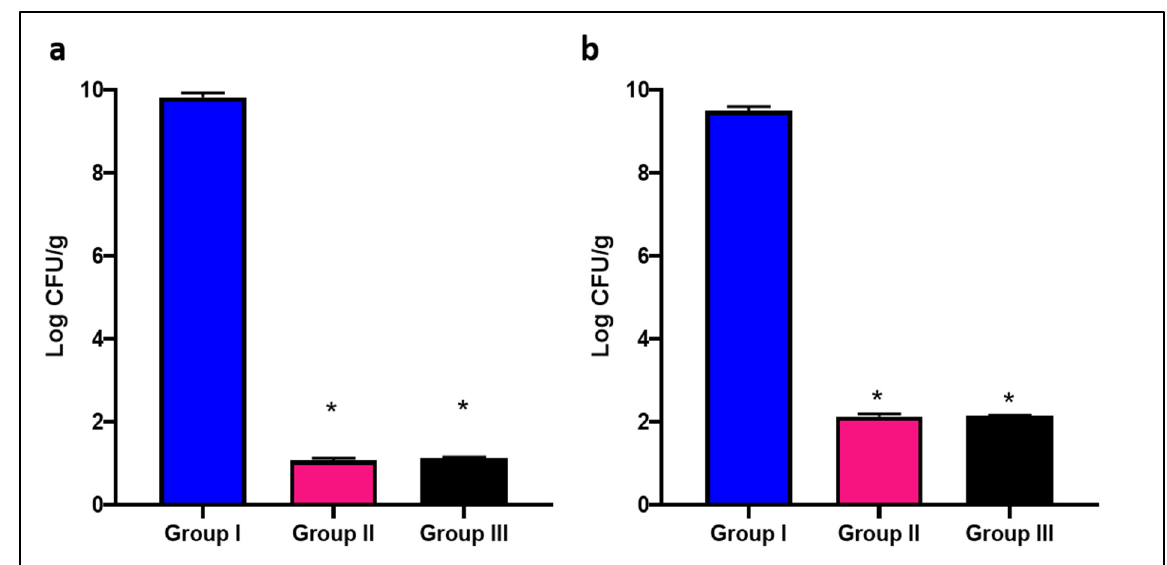
Figure 6. Bar chart showing the number of CFU/mL of S. aureus isolates in ( a ) liver and ( b ) spleen in the different experimental groups. The symbol (*) represents a significant decrease ( p < 0.05) in comparison with group I.